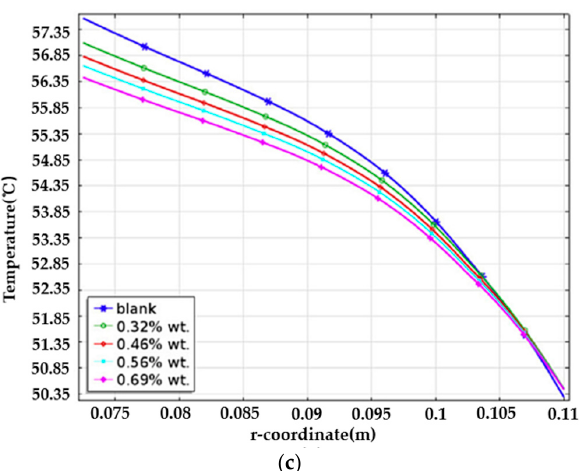
Figure 4. The effect of different carbon fiber loadings on the battery: ( a ) the change of the battery surface temperature with time; ( b ) the change of the battery surface temperature with the height; ( c ) the change of the radial battery temperature [38]. Reproduced from reference 38 with permission from Elsevier B.V., copyright 2016.